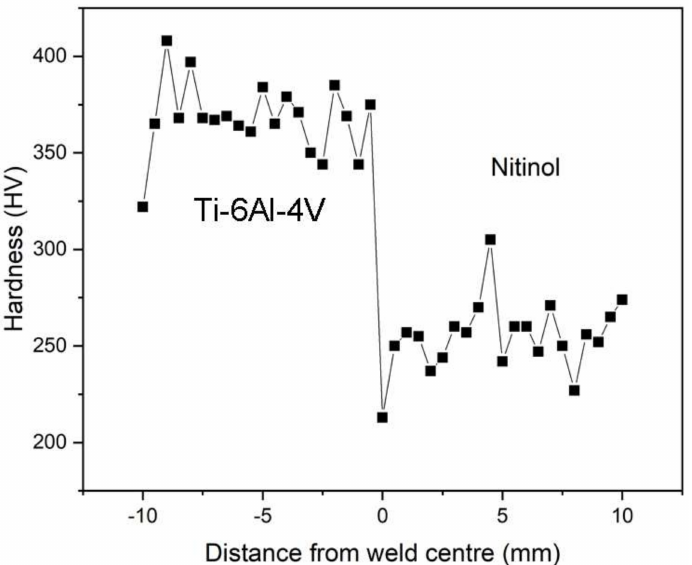
Figure 8. The hardness distribution across the interface of dissimilar Ti-6Al-4V/Nitinol